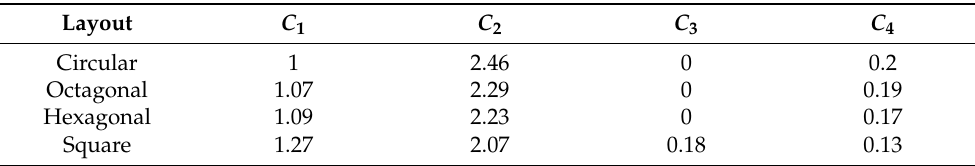
Figure 2. Symmetrical spiral planar inductors ( a ) square ( b ) Hexagonal ( c ) Octagonal ( d ) Circular. Table 1. Geometrical coefficients for current sheet expression [23].